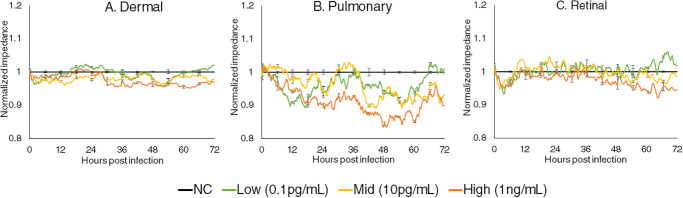
Normalized real-time impedance changes in (A) Dermal MEC, (B) Pulmonary MEC and (C) Retinal MEC treated with low (0.1pg/mL), medium (10pg/mL) and high (1ng/mL) levels of NS1 antigens. The measured impedances of the treated MECs were normalized to the un-treated cells and the standard error of mean between biological triplicates were represented as error bars.